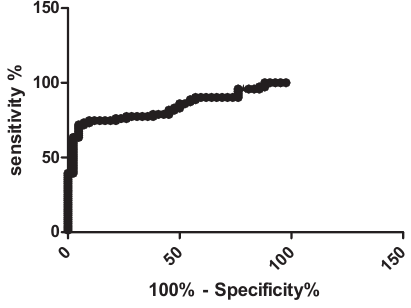
Fig. 4. ROC curve of LDF and REG. Area under curve (AUC): 0.8394 with p<0.0001; Std. error: 0.03693; 95 % confidence interval: 0.7670 to 0.9118. Figure and numbers are presented as Prism program shown and calculated from the percent values of REG and LDF signals